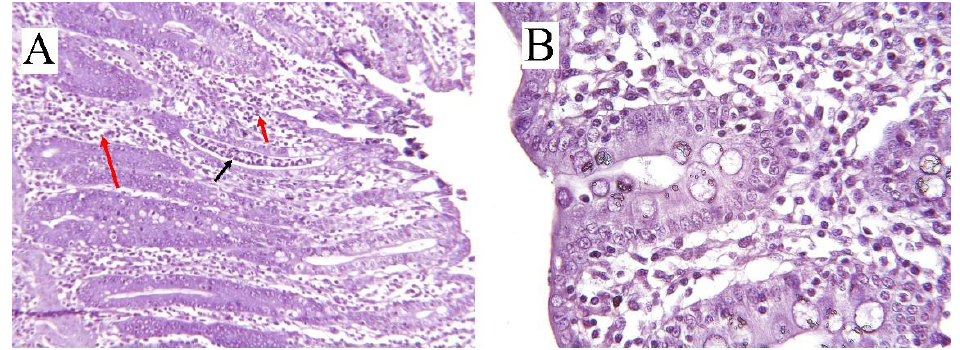
Figure 2. ( A ) Cross-sectional histology (hematoxylin/eosin-stained) of inflamed colon in pig (8 weeks old) with ×10 scale of magnification. Infiltration of neutrophils (black arrow) and mononuclear cells (red arrows) in the crypts can be seen. ( B ) Colonic cross-sectional histology of a healthy pig (11 week) with ×25 scale of magnification.